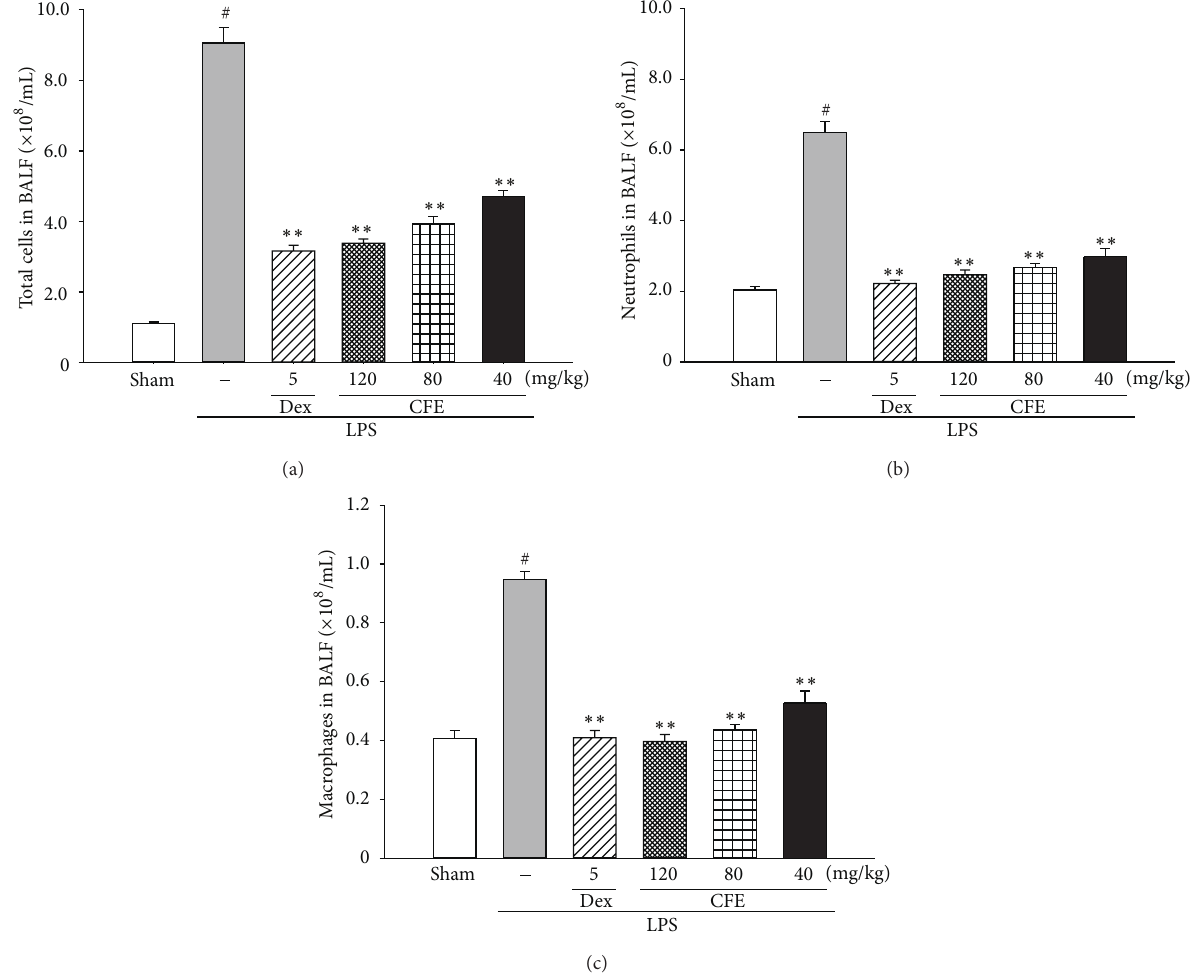
Figure 3: The effects of CFE on total cells (a), neutrophils (b), and macrophages (c) in BALF. Data was represented as the mean ± SEM ( 𝑛 = 10 ). # 𝑃 < 0.01 compared to the sham group; ∗ 𝑃 < 0.05 and ∗∗ 𝑃 < 0.01 compared to the LPS